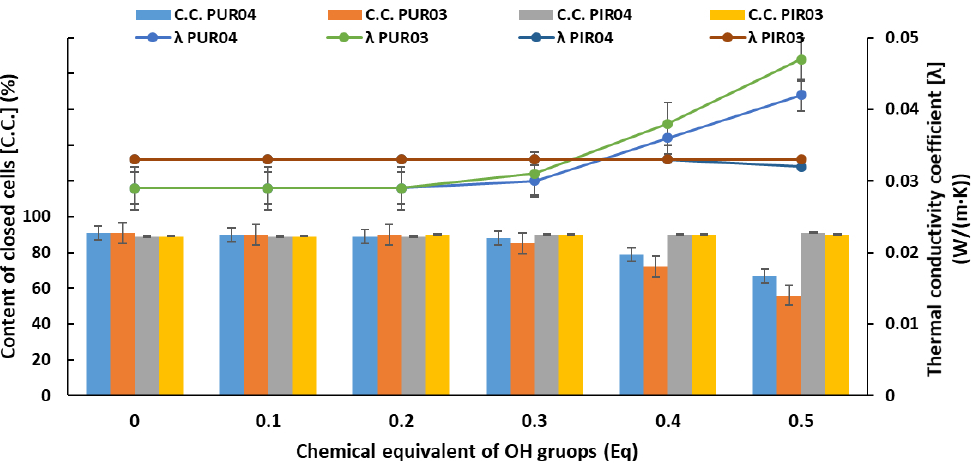
Figure 10. Dependence of the content of closed cells, the thermal conductivity coefficient and the content of eco-polyols based on PLA waste.